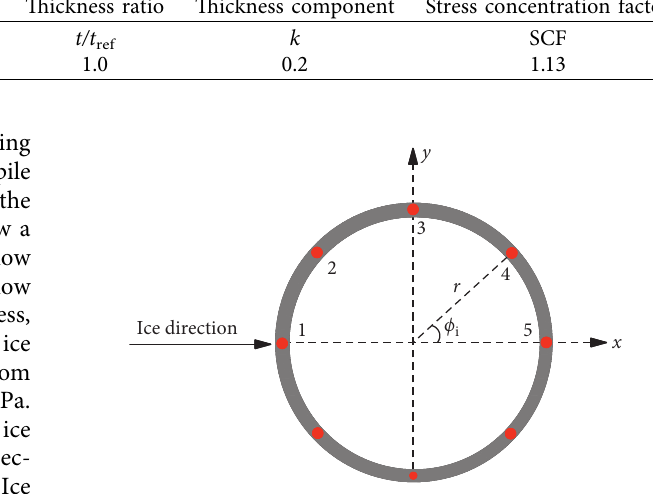
Figure 11: Selected stress points distributed along the pile cross